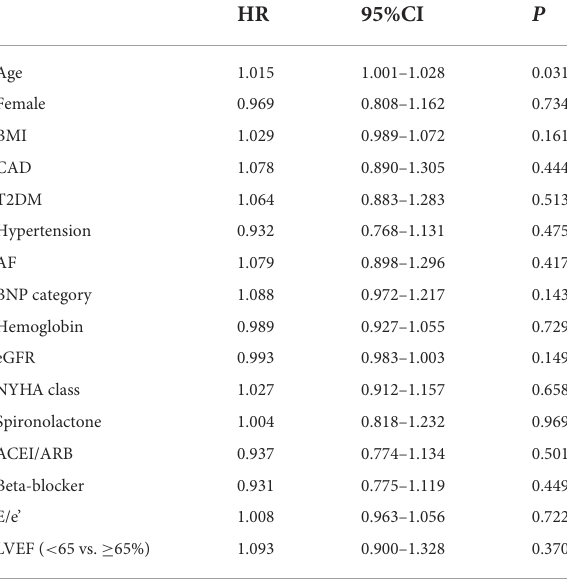
TABLE 7 Multivariable cox analysis for composite endpoints in HFpEF patients with LVEF ≥